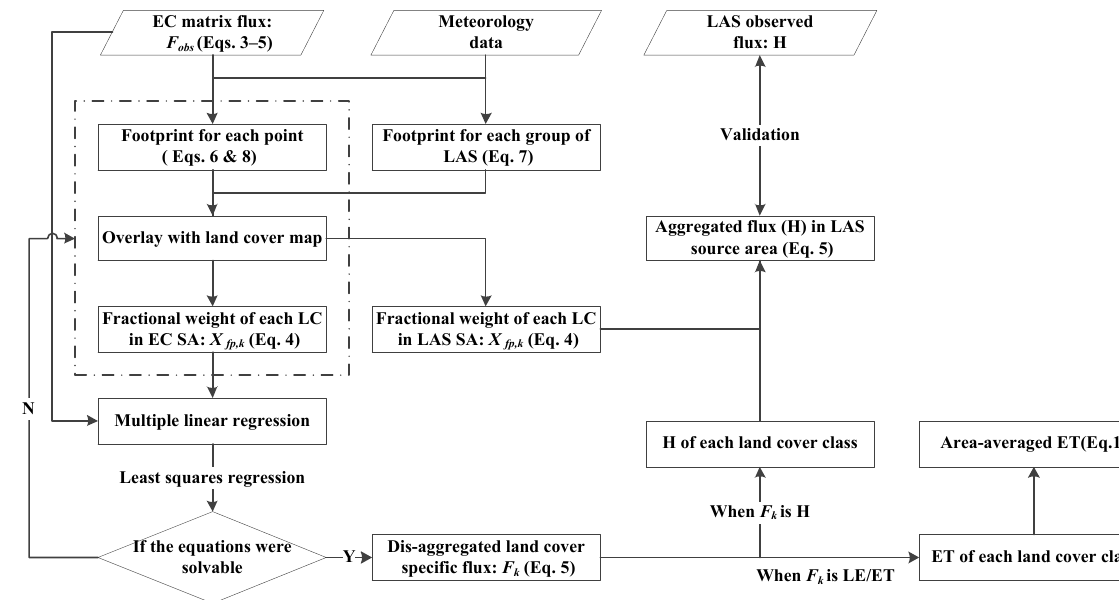
Figure 2. Schematic illustration of data processing steps; LC: land-cover class; SA: source area; H: sensible heat flux; LE: latent heat flux; ET: